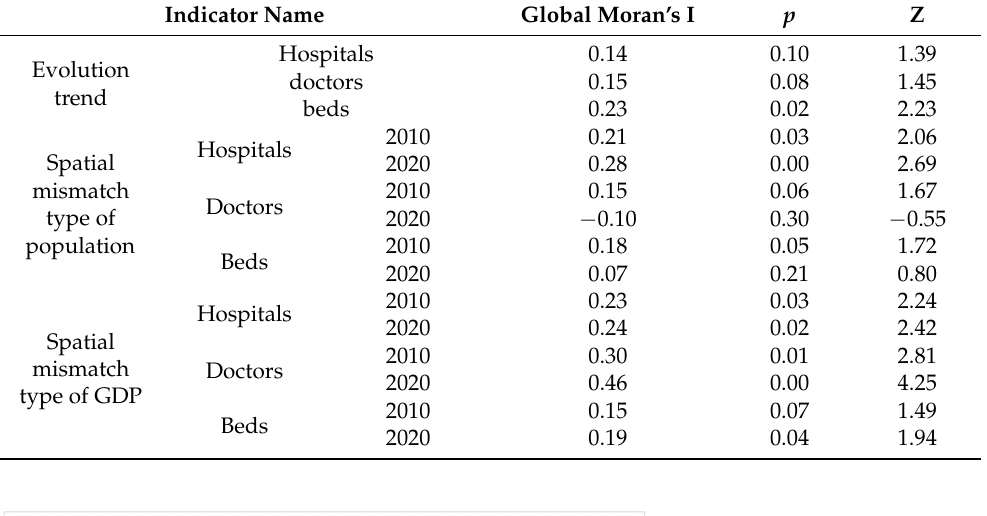
Table 2. Parameters for global autocorrelation analysis.